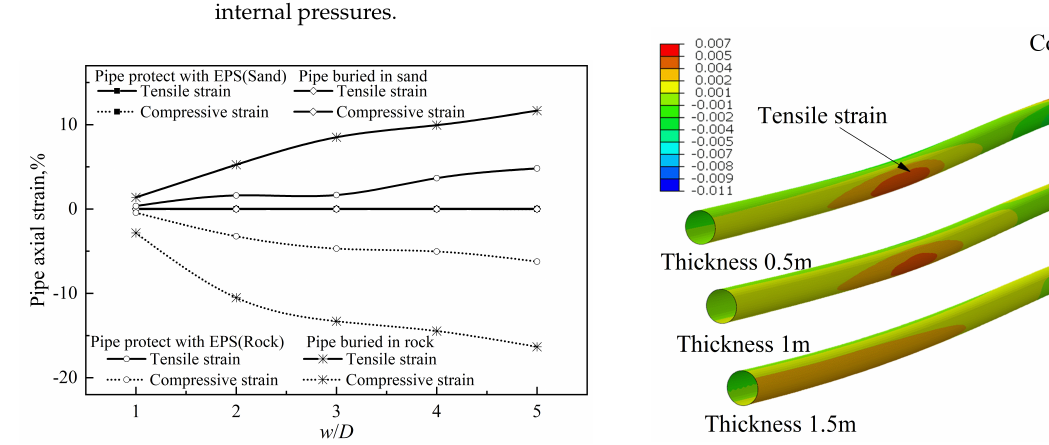
Fig. 11. Ovalisation parameter of pipe in different soils.